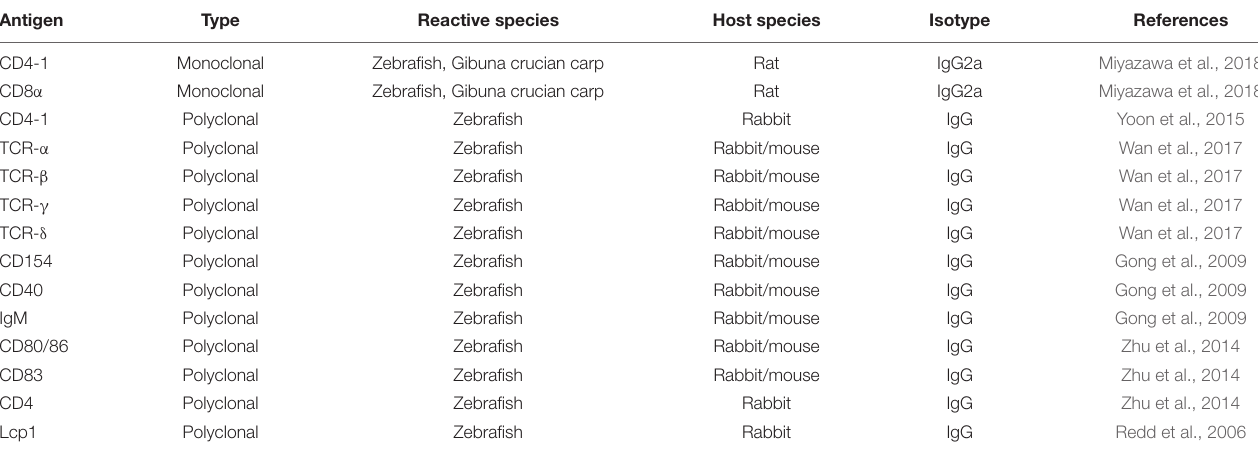
TABLE 2 | Antibodies recognizing markers of zebrafish immune cells.